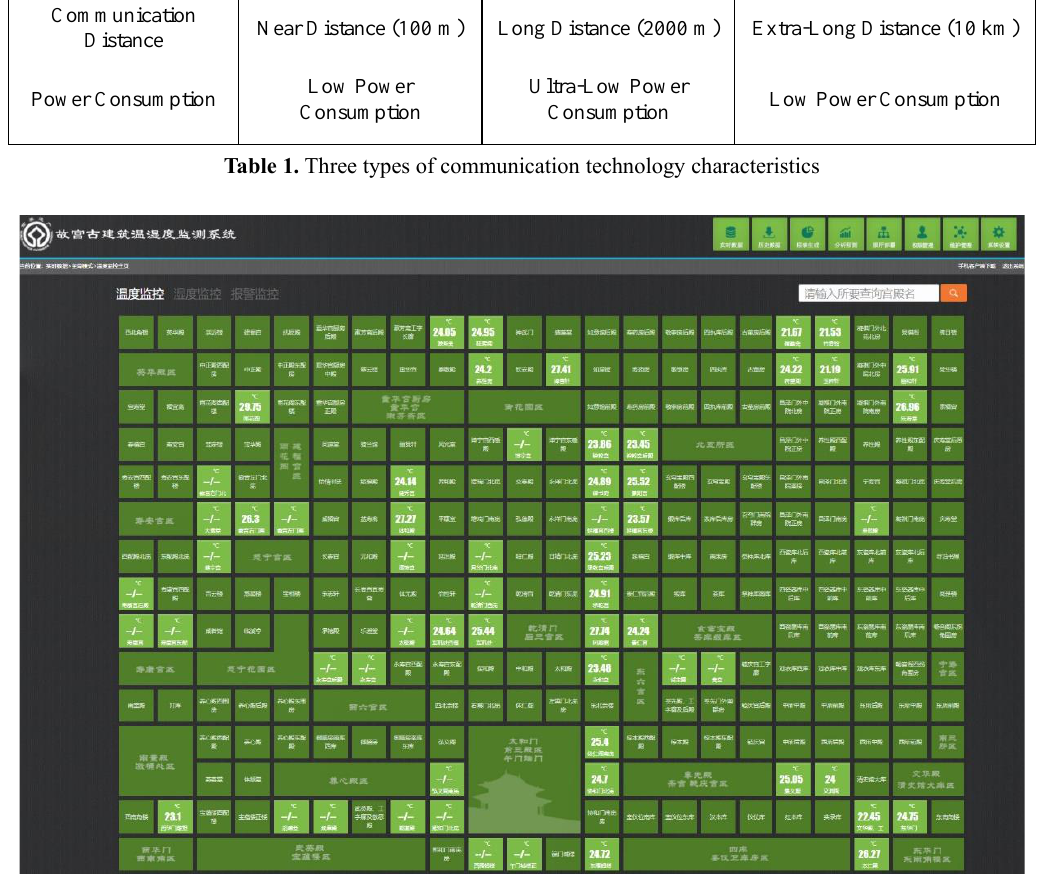
Figure 2. Real-time data of the indoor micro-environment monitoring